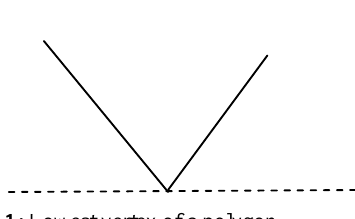
Figure 1: Lowest vertex of a polygon